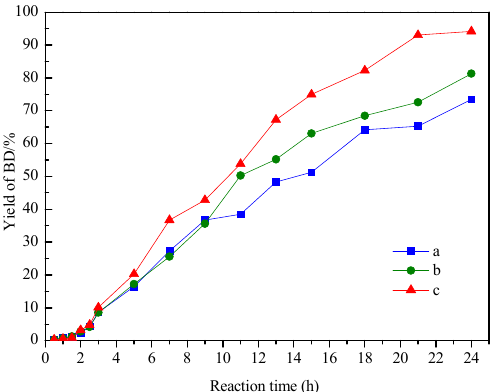
Figure 11. The yield of 1,4 ‐ butynediol (BD) by Cu 2 O catalysts. ( a ) Cu 2 O ‐ NO 3 ; ( b ) Cu 2 O ‐ Cl(1); ( c ) Cu 2 O ‐ Cl(2). Reaction conditions: catalyst amount, 0.5 g, formaldehyde solution concentration, 39 vol. %, consumption of the formaldehyde solution, 50 mL, reaction temperature, 90 °C.